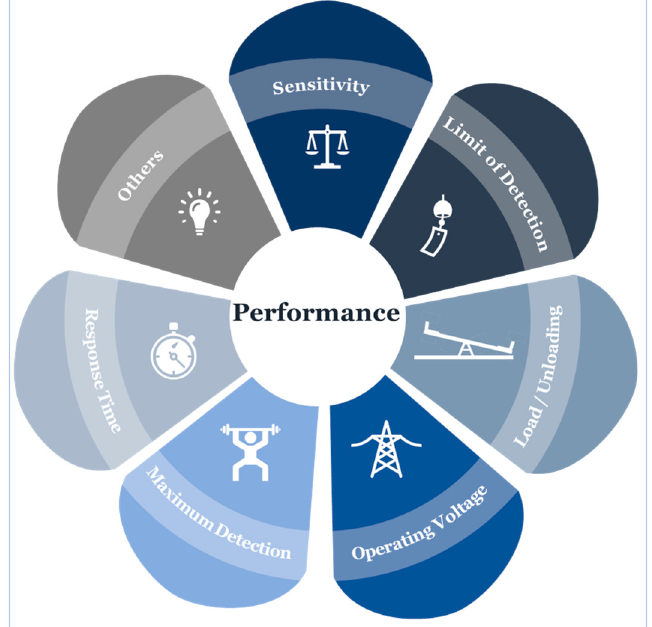
Figure 7. Essential performance elements necessary for accurate and continuous blood pressure measurement when compared to a gold standard.